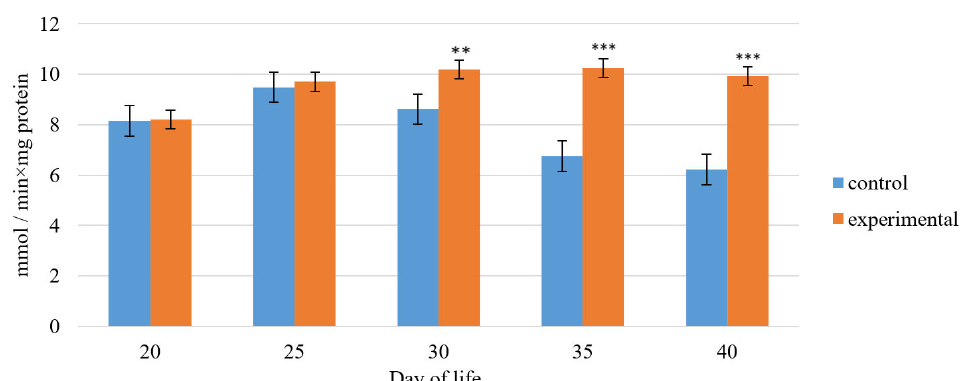
Fig. 4. Glutatine peroxidase activity in the blood of piglets under the action of feed additive “Butaselmevit-plus”